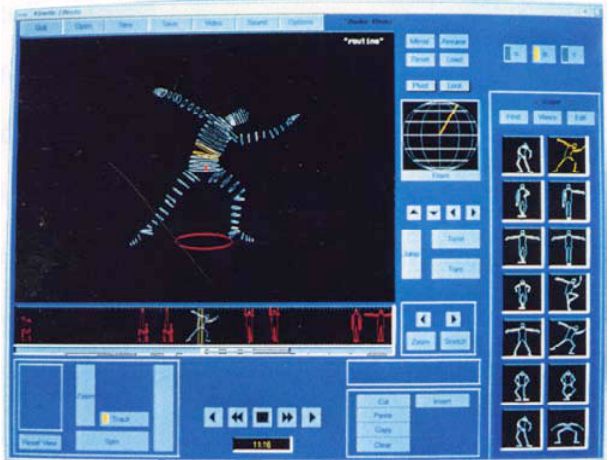
Figure 3.3 Sequence Editor Version of